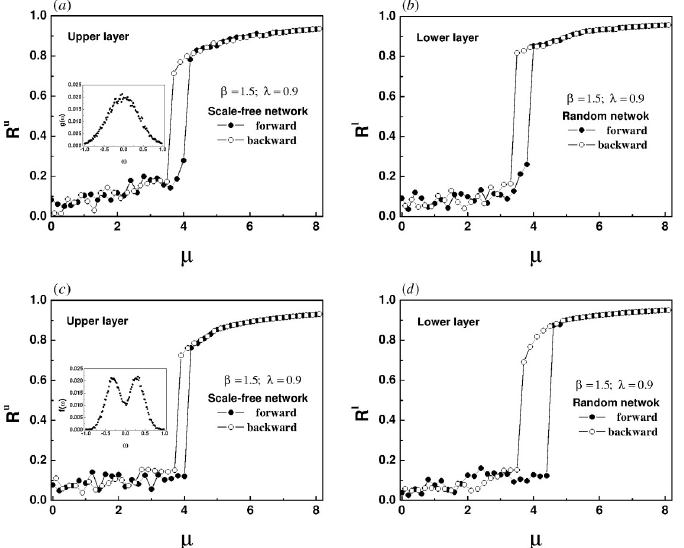
Fig 13. Synchronization and desynchronization transition diagrams of each layer at different natural frequency distributions. The topology of the network is exactly the same as Fig 12. We replace the random uniform distribution by two symmetric frequency distributions. The small inset in Fig 13a is a unimodal Gaussian distribution, in which the parameters are set to ω 0 = 0 and σ 2 = 0.16. The small inset in Fig 13c is a bimodal Gaussian distribution, in which the parameters are set to A = 20.3108, B = 0.1667, ω 0 = 0 and σ 2 = 0.0566.